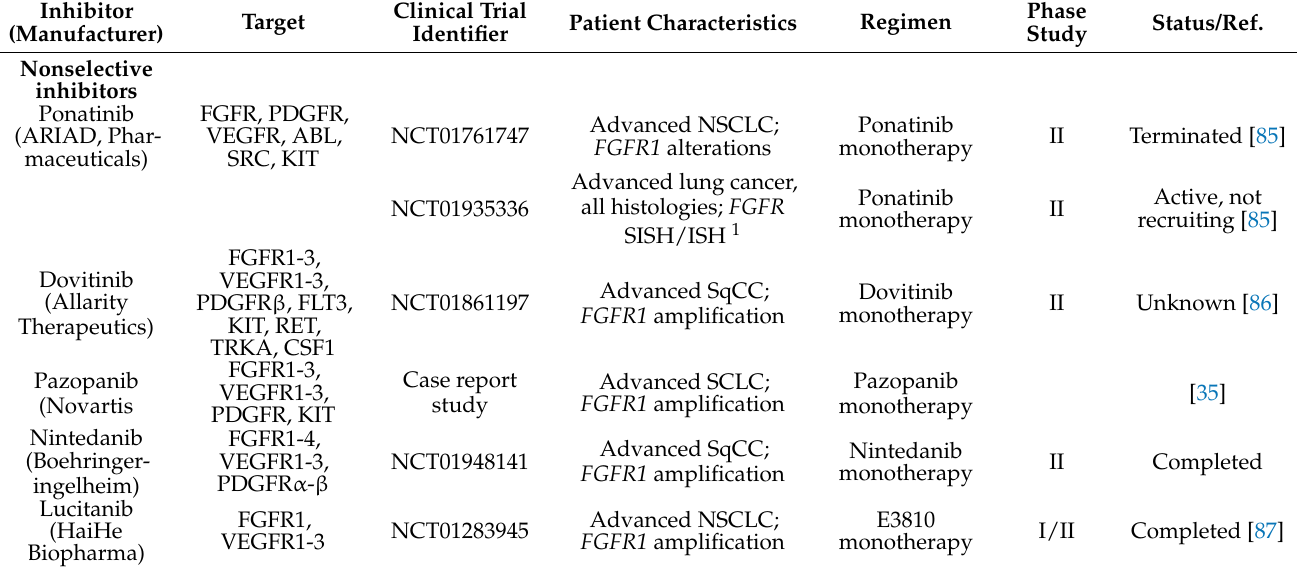
Table 2. Key clinical trials evaluating lung cancer patients harbouring FGFR alterations. Details for trials with NCT numbers can be accessed on https://clinicaltrials.gov (accessed on 2 April